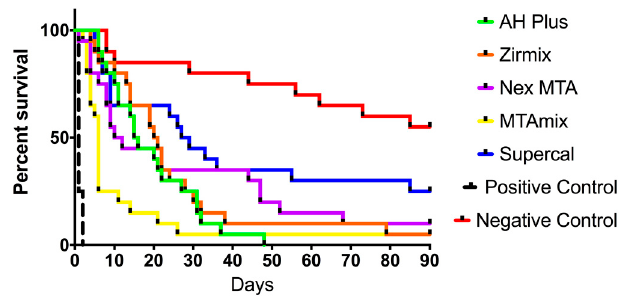
Figure 3. Kaplan–Meier survival curves for endodontic materials subjected to challenge from salivary bacteria over 90 days. Table 2. Median survival in days for endodontic obturation materials and controls.